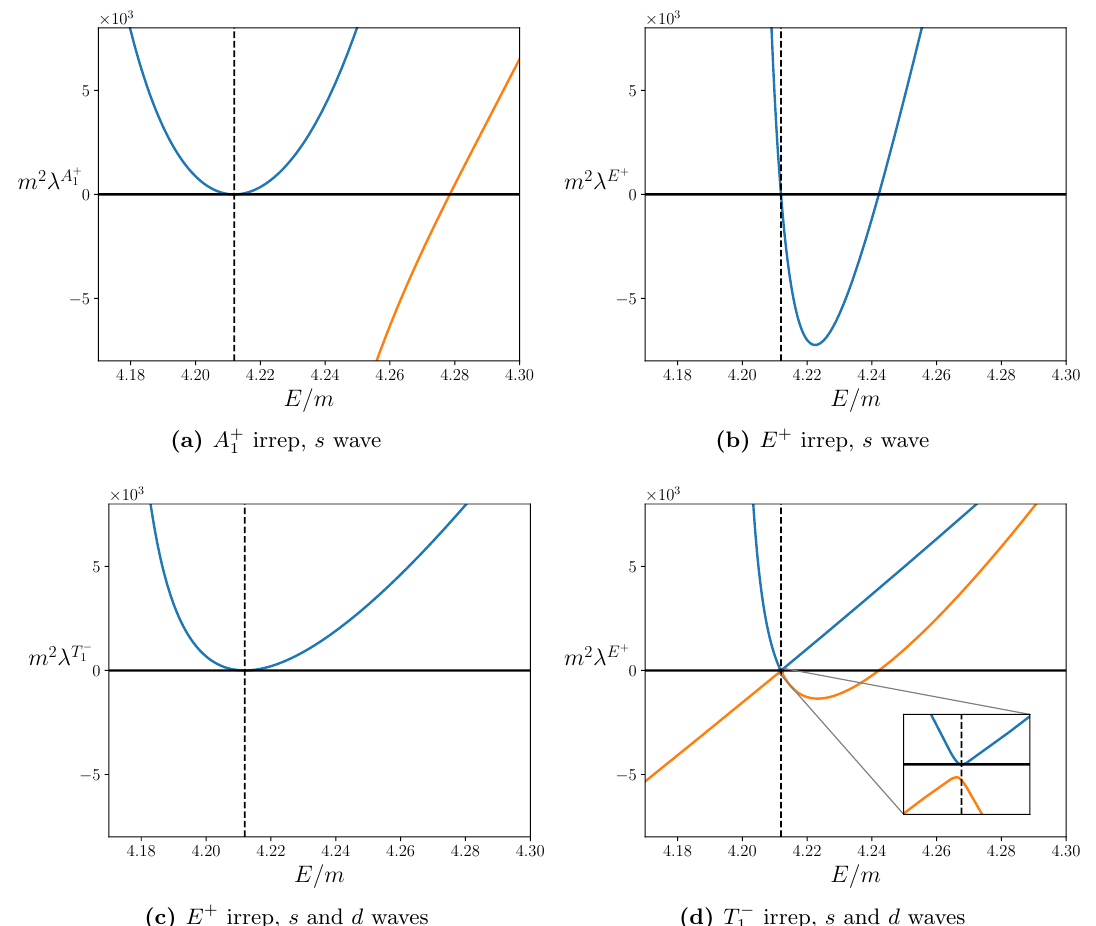
Figure 11. Examples of solutions to the quantization condition for = 0 occurring at the free K df ; 3 energy E free (shown in all plots as the vertical dashed line). Plots show eigenvalues of F (cid:0) 1 as a 1 3 function of E=m , with ma 0 = 0 : 1, r 0 = P 0 = 0 and mL = 5. Solutions to the quantization occur when an eigenvalue crosses zero. (a) A + irrep with only ‘ = 0 channels; (b) E + irrep, with only 1 ‘ = 0 channels; (c) T (cid:0) irrep, with both ‘ = 0 and 2, and ma 2 = 0 : 1; (d) E + irrep, with both ‘ = 0 1 and 2, and ma 2 = 0 : 1. For the E + / T (cid:0) irreps, all eigenvalues are doubly/triply degenerate. In (d), 1 both apparent crossings are in fact avoided, as illustrated by the